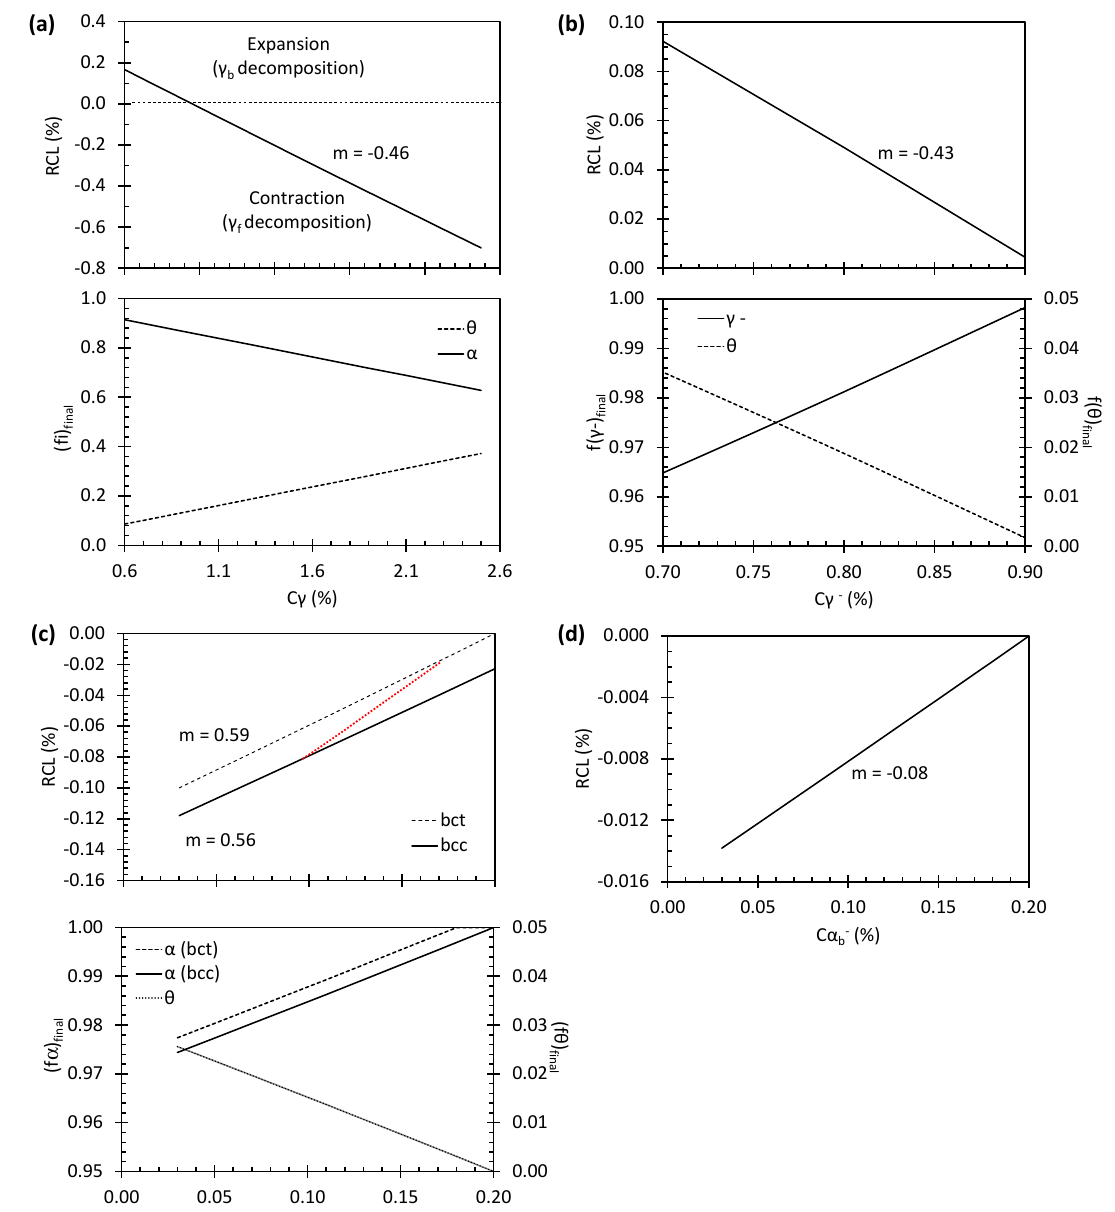
Figure 5. Theoretically calculated relative change in length (RCL) and volume fraction of relevant phases involved in the different scenarios described in the main text and detailed in Table 5, ( a ) scenario 1, ( b ) scenario 2, ( c ) scenario 3, and ( d ) scenario 4. The slope of the RCL as function of carbon content is reported as m.